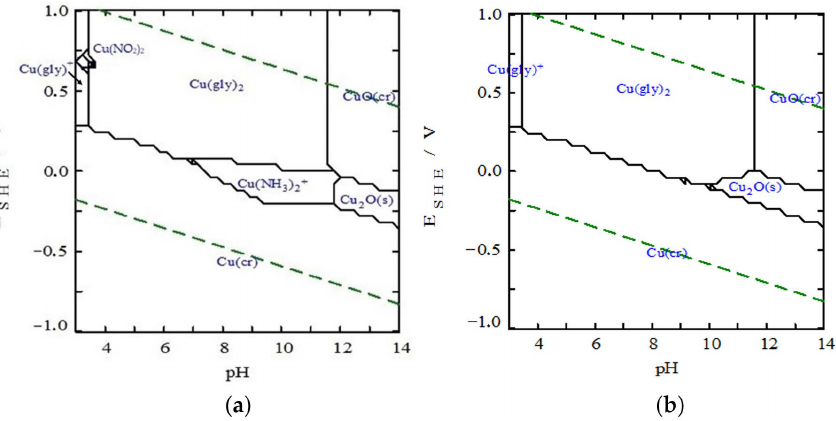
Figure 6. Eh-pH diagrams of ( a ) glycine-ammonia–copper–water system and ( b ) glycine–copper– water system (with 270 mM glycine, 50 mM copper and at 25 ◦ C (for a , b ) and with 2.43 M ammonia (for a ), made by Medusa-Hydra software (available at https://www.kth.se/che/medusa/ accessed on 6 February